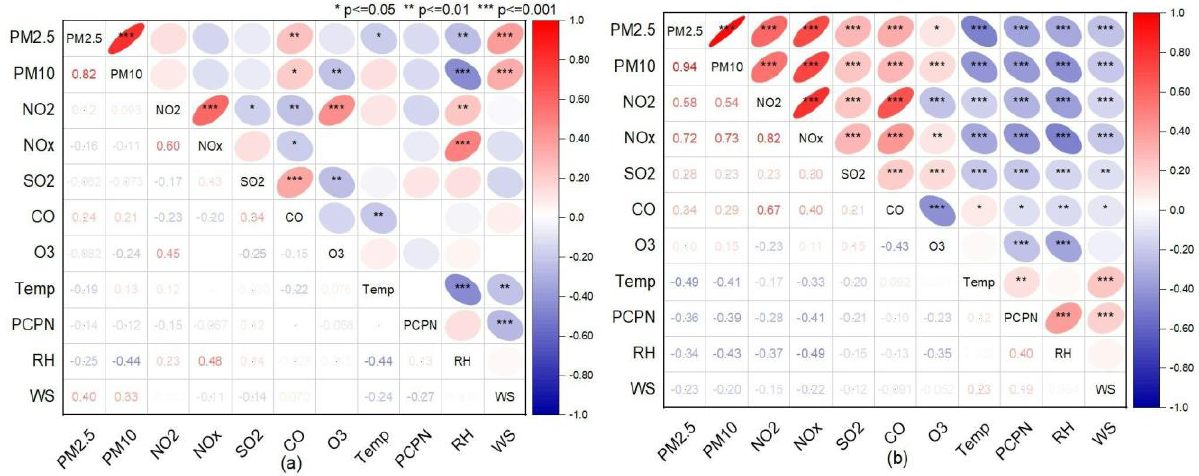
Figure 4. Correlation matrix of meteorological variables with pollutants at ( a ) site #1 and ( b ) site #2. (above diagonals: the more distorted the circle and darker the color, the closer the correlation was to 1; white: no correlation, blue: negative correlation, red: positive correlation; below diagonals: value of r, Pearson correlation coefficient; *: p < 0.05, **: p < 0.01; ***: p < 0.001).